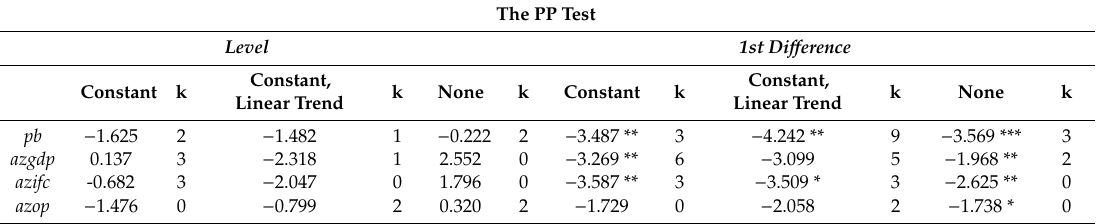
Table A12. AZ. The Unit Root test